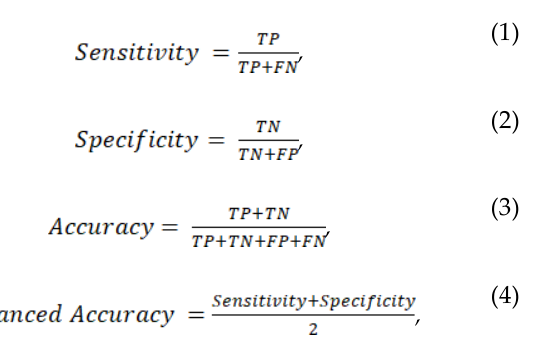
Table 3. The final datasets comprised motion data from 21 participants. Two datasets were collected in the trial, i.e. dataset-CR (chest rotation) and dataset-PR (pelvis